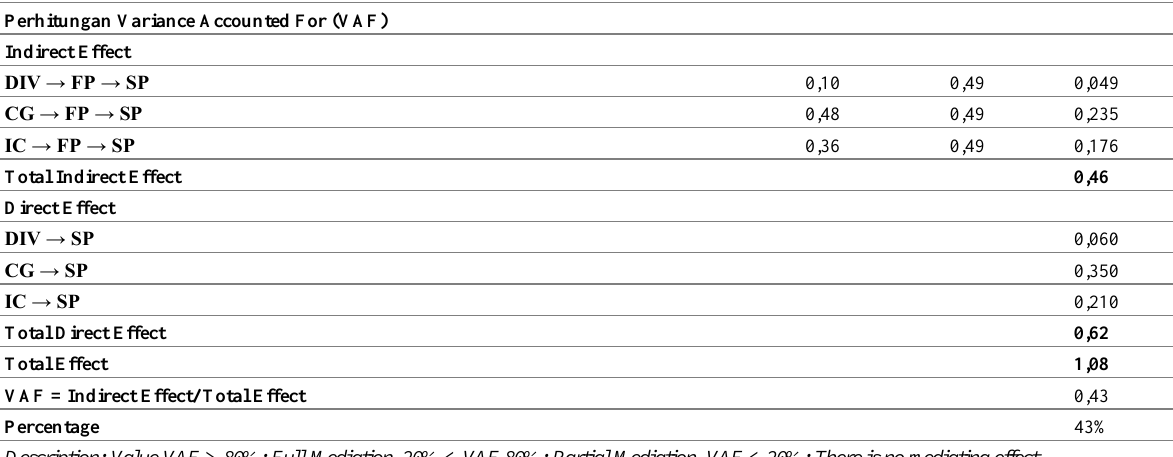
Table 2: Testing for Mediation